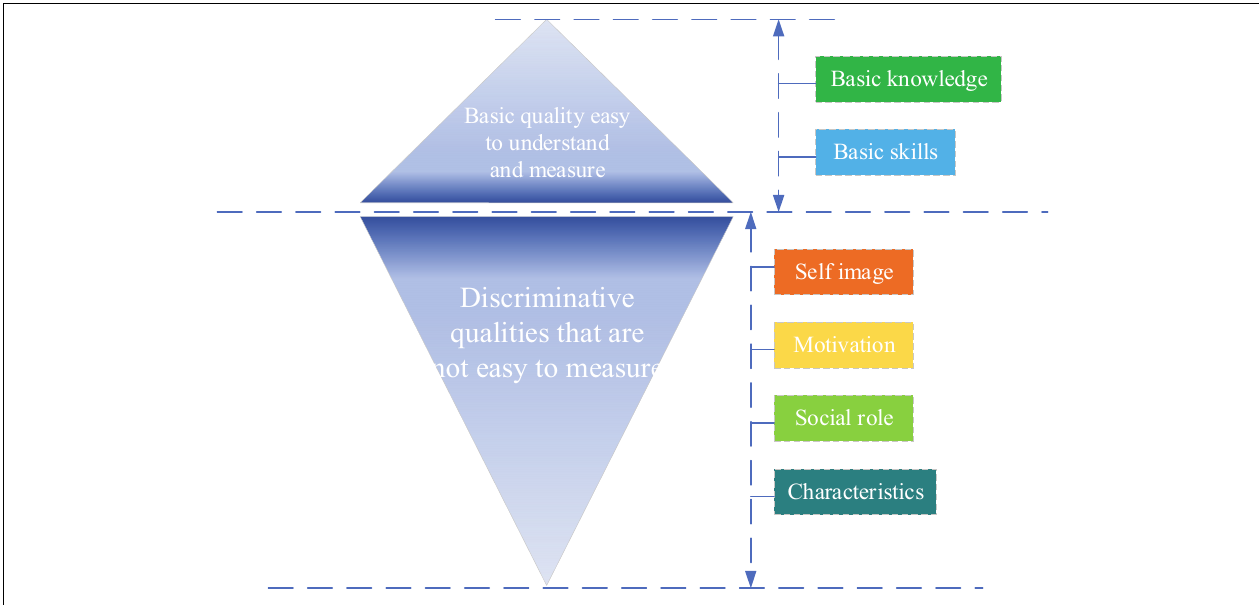
FIGURE 1 | Iceberg model for quality.